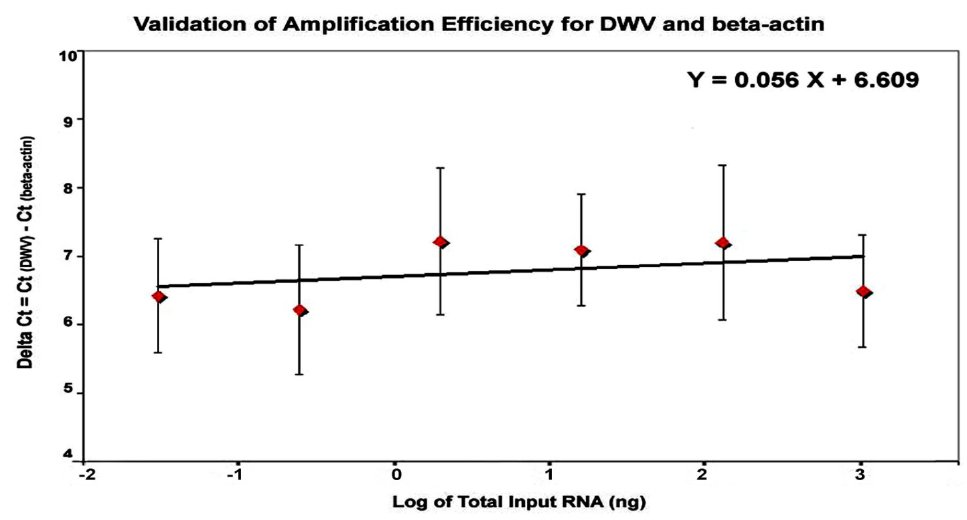
Figure 6. Validation of amplification efficiency for DWV and β -actin by TagMan qRT-PCR. The amplification of six five-fold dilutions of total RNA ranging from 1 μ g to 0.32 ng per reaction was performed in triplicate and the standard curves for DWV and β -actin were generated by plotting the C value against the corresponding input RNA. The T difference between the C value of DWV and that of β -actin ( Δ Ct) was plotted against the T log of the corresponding amounts of input